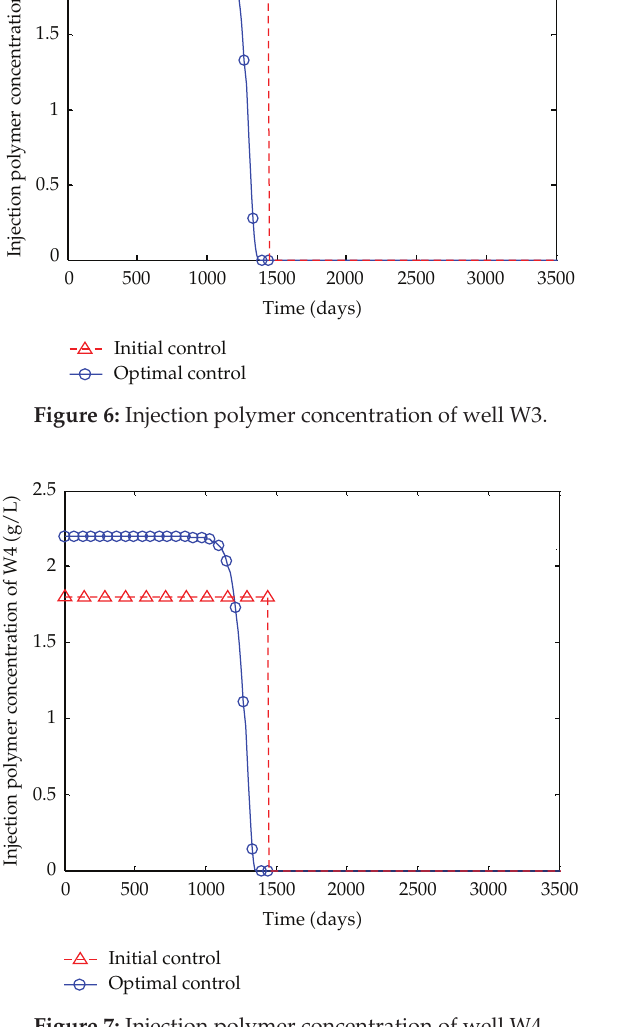
Figure 7: Injection polymer concentration of well